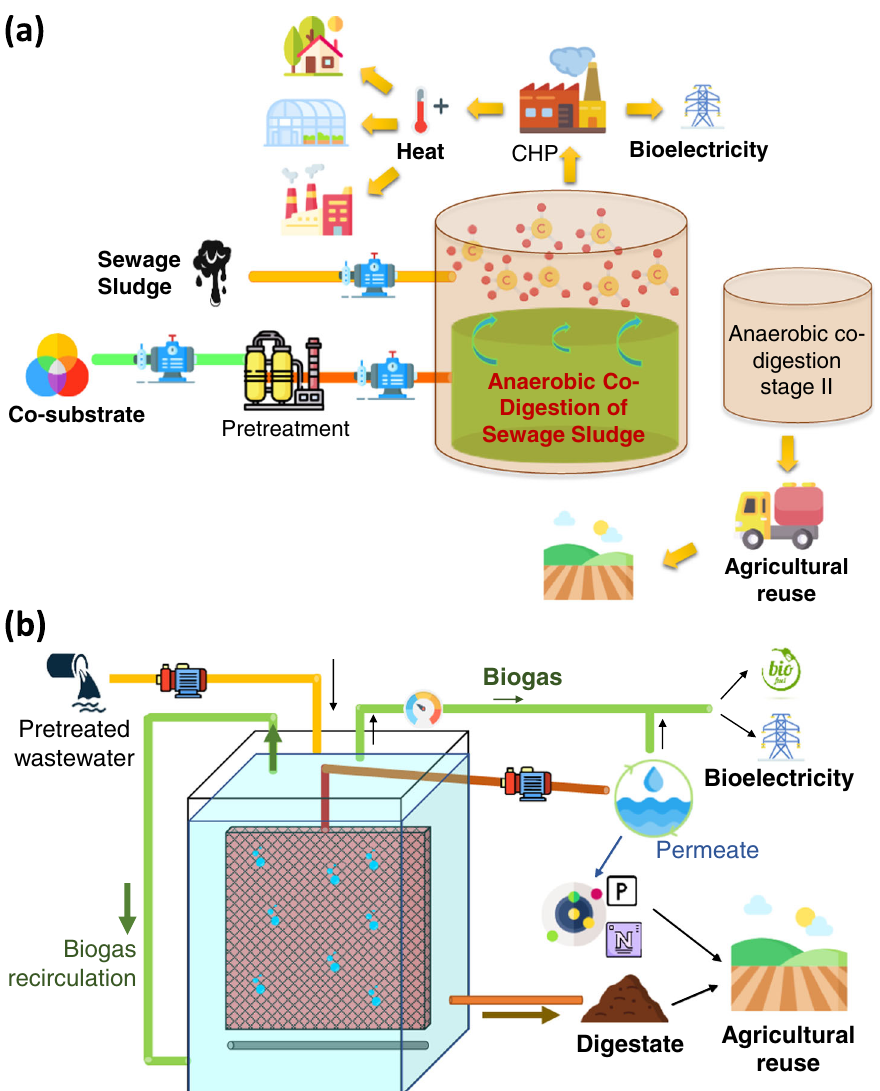
Fig. 1 Process fl ow diagram of typical anaerobic systems used for wastewater treatment. a Anaerobic digestion and b Anaerobic membrane bioreactor. Credit: www. fl aticon.com for the